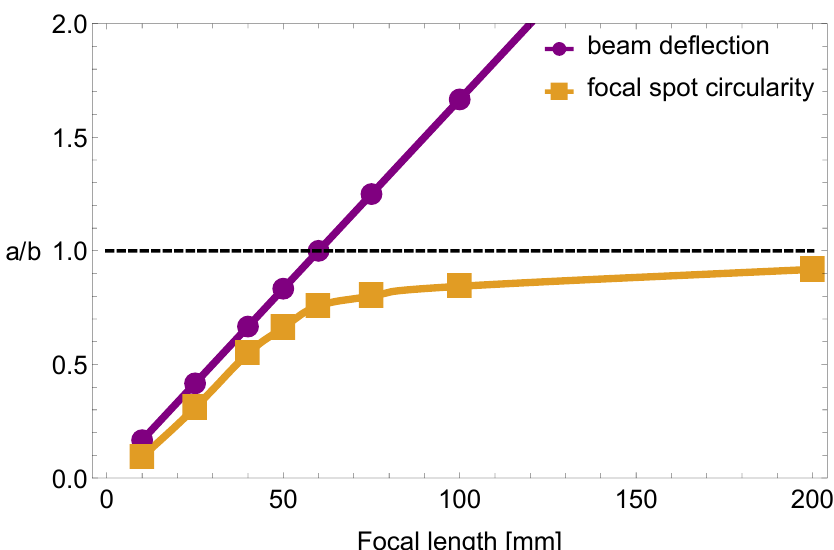
Figure 8. The dependence of the circularity of the focal spots (orange line) and the beam deflection (purple line) on the focal length of the designed lens. The circularity of the spot is defined as the ratio of its diameters measured along horizontal and vertical axes (a/b). The beam deflection denotes the tangent of the angle between the lens surface and the deflected